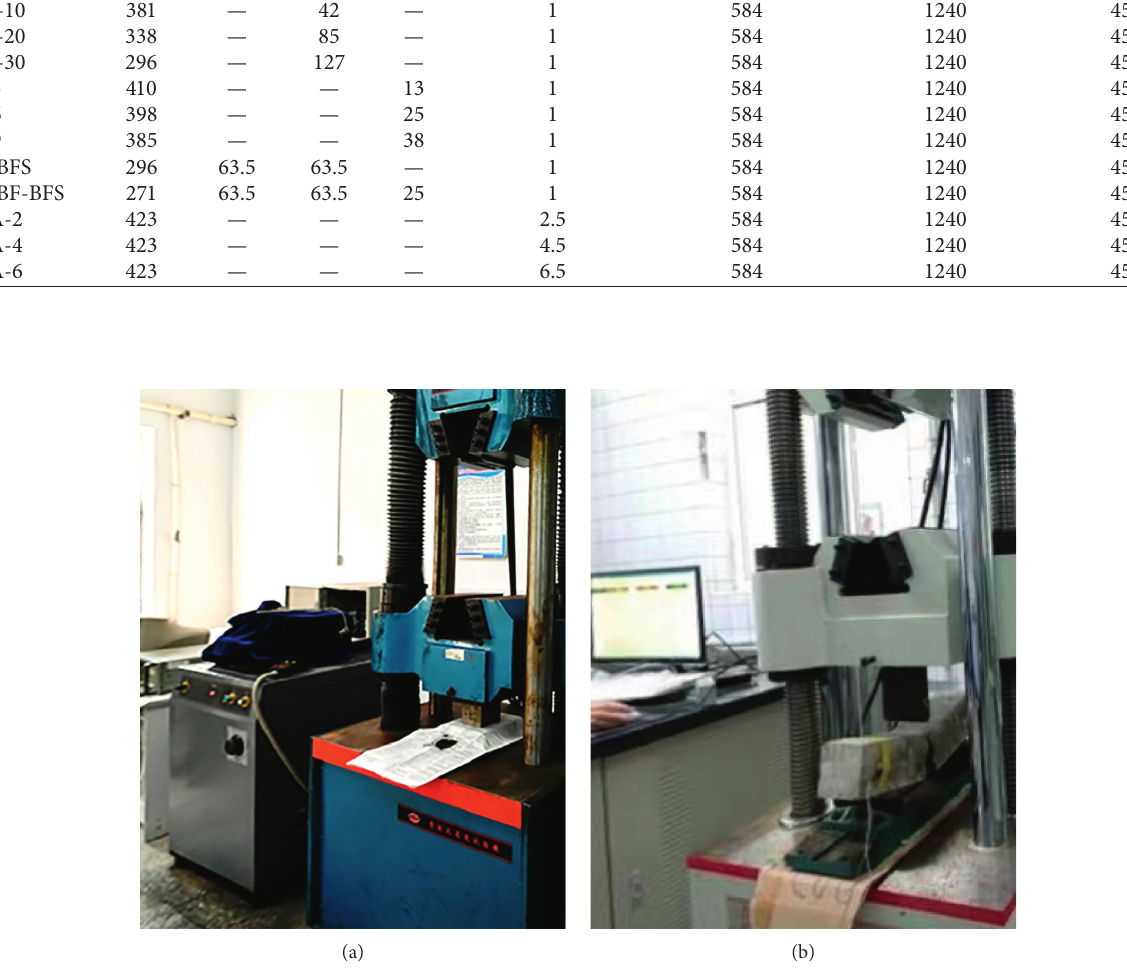
Figure 2: Mechanical performance tests of cement concretes used in this paper. (a) Compressive strength test. (b) Flexural strength test.